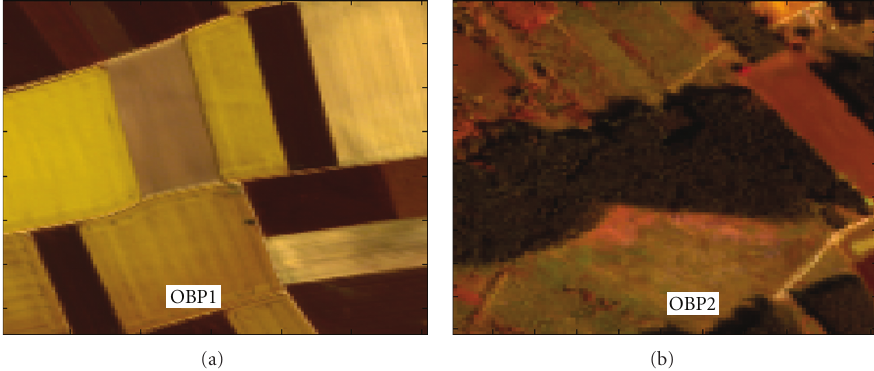
Figure 2: RGB composite of the original data cubes. From left to right: OBP1, OBP2.